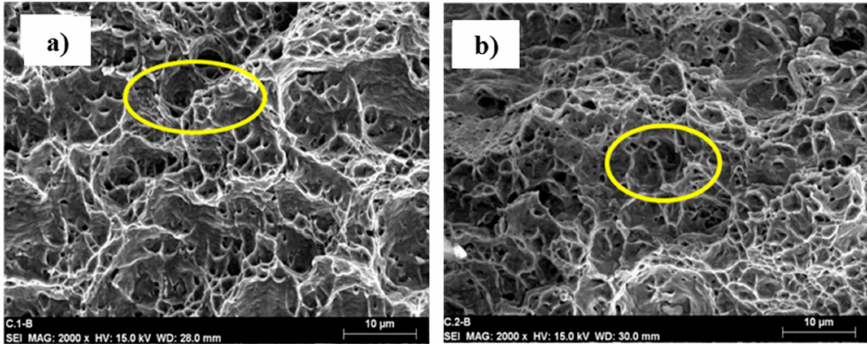
Figure 13. Fracture of the GMAW-P-brazing for ( a ) low heat input and ( b ) high heat